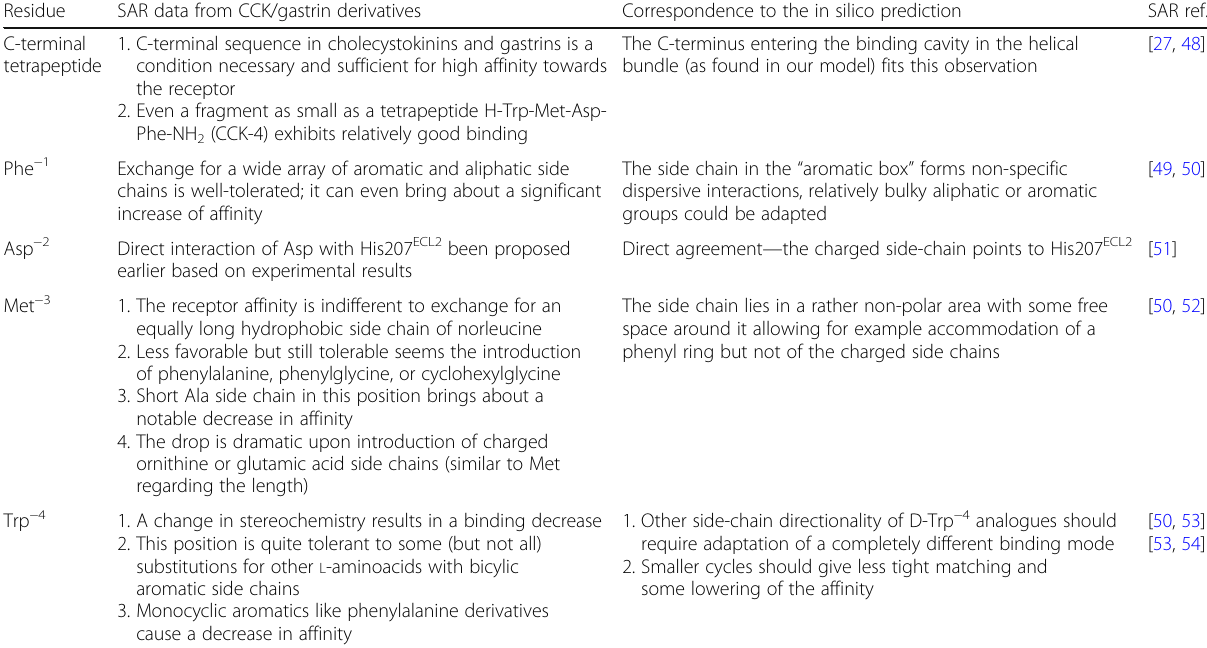
Table 3 SAR data from CCK/gastrin derivatives and their correspondence to our model